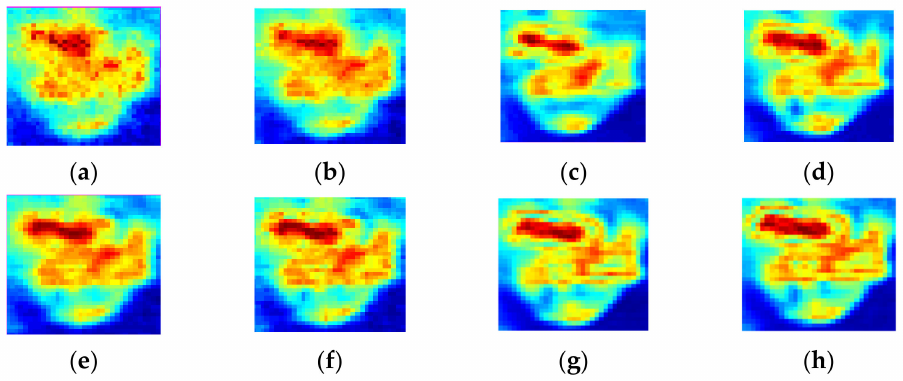
Figure 3. Reconstruction images of different methods for the sample at different sampling rates in the selected areas. ( a ) SSC at SR = 20%; ( b ) DSC at SR = 20%; ( c ) HSM at SR = 20%; ( d ) GSNS at SR = 20%;